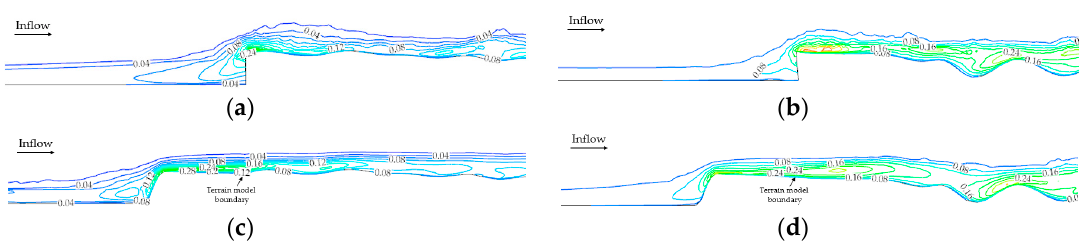
Figure 11. Turbulence kinetic energy distribution along the inflow direction near the inlet of the terrain model without or with improved BTS from CFD simulation (unit: m 2 s − 2 ). ( a ) Case 1 without BTS; ( b ) Case 2 without BTS; ( c ) Case 1 with BTS; ( d ) Case 2 with